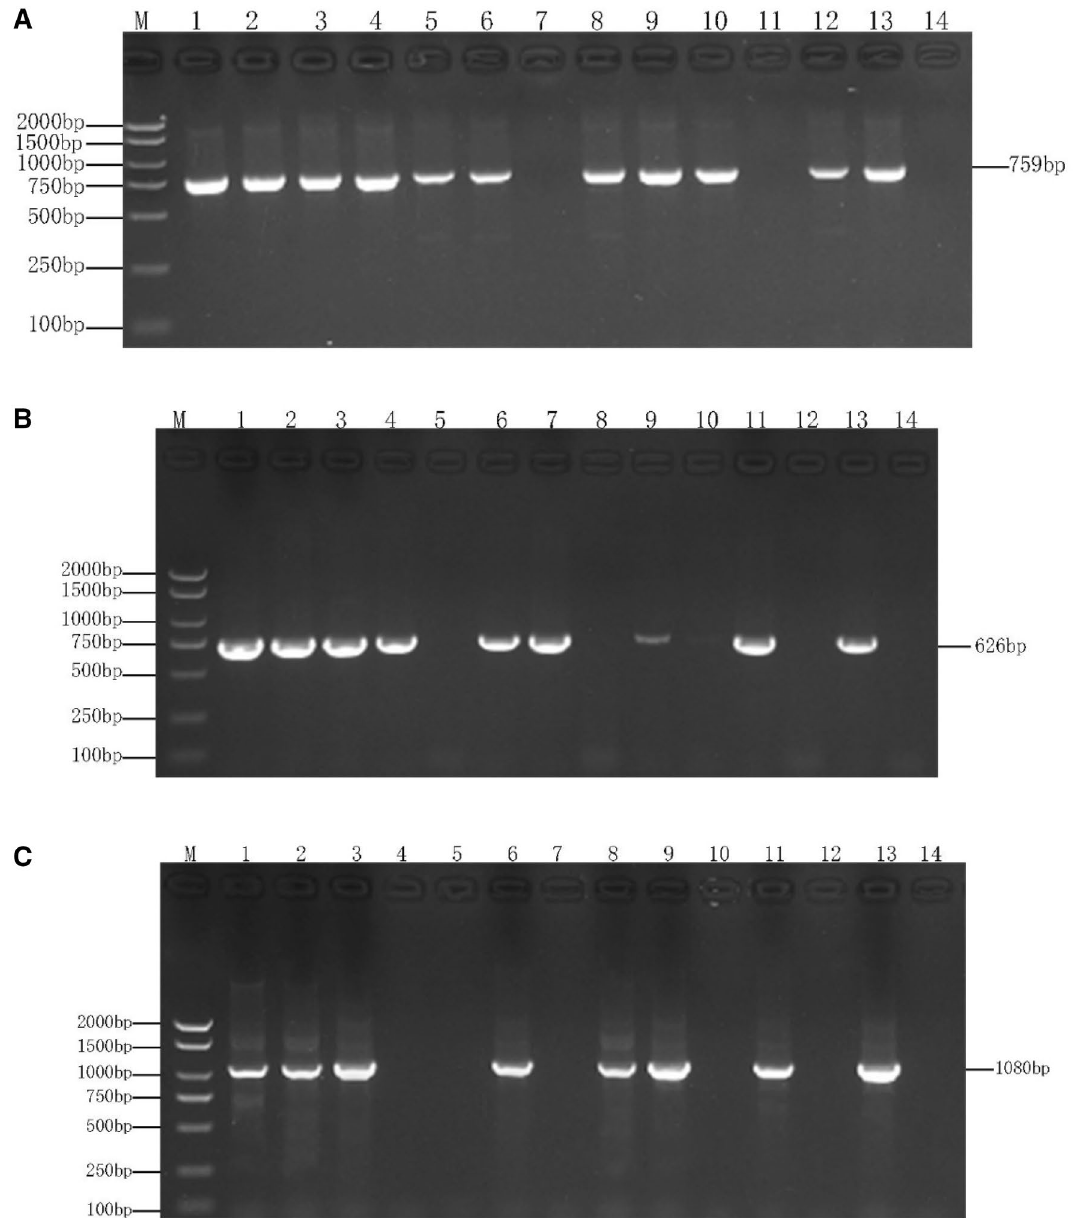
Figure 3. ( A ) Genotypic identification of bla CTX-M gene via PCR in E. coli strains isolated from beef cattle in china’s Sichuan-Chongqing Circle; where, M: 2000 bp DNA Marker, 1: positive controls, 7 and 11: CTX-M negative isolates while others are positive, and 14: negative controls. Original Images of full-length gels are presented in Supplementary Fig. 4. ( B ) Genotypic identification of bla SHV gene via PCR in E. coli strains isolated from beef cattle in china’s Sichuan-Chongqing Circle; where, M: 2000 bp DNA Marker, 1: positive controls, 5, 8, 10, and 12: SHV negative isolates while others are positive, and 14: negative controls. Original Images of full-length gels are presented in Supplementary Fig. 5. ( C ) Genotypic identification of bla TEM gene via PCR in E. coli strains isolated from beef cattle in china’s Sichuan-Chongqing Circle; where, M: 2000 bp DNA Marker, 1: positive controls, 4, 5, 7, 10 and 12: TEM negative isolates while others are positive, and 14: negative controls. Original Images of full-length gels are presented in Supplementary Fig. has become another challenge for drug resistance control in China, which is not easily restricted compared to the health-care system. Among the ESBL positive E. coli , the results showed that the phylogenetic group A was the most common, followed by B1 and B2 phylogenetic groups. However, there were only 5 positive isolates in phylogenetic group D. It has been previously reported that phylogenetic groups A isolated from animals were more common in tropical regions 45,46 , phylogenetic group B1, B2 and D are said to be associated with ExPEC infections in humans and animals 47,48 . Thus, the distribution of phylogenetic groups may be affected by their geographical region,